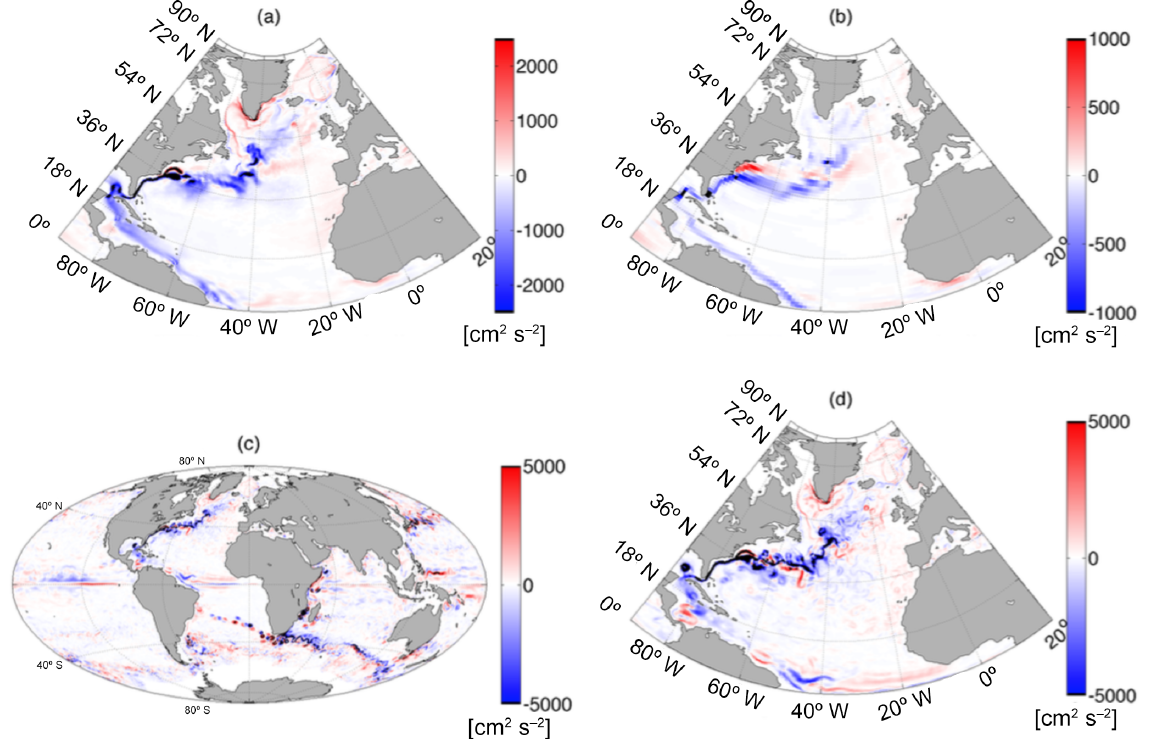
Figure 5. Difference of horizontal surface kinetic energy (energy flux per unit area) in cm 2 s − 2 of the simulations (a) R 021 and (b) R low the North Atlantic (mean of years 2081–2100 minus mean of years 2001–2020). (c) shows the difference in eddy kinetic energy (EKE) of the years 2090 and 2010 of R 021 . Before computing EKE, the mean KE of the years 2080–2100 and 2000–2020 has been subtracted. (d) is the same as (c) showing only the North